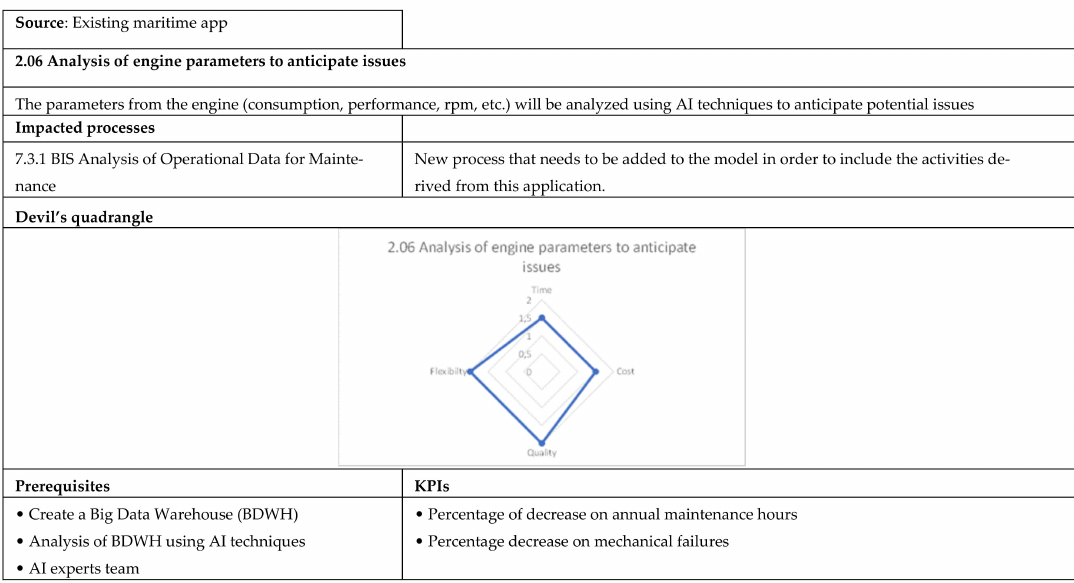
Figure A10. Analysis of engine parameters to anticipate issues data sheet.